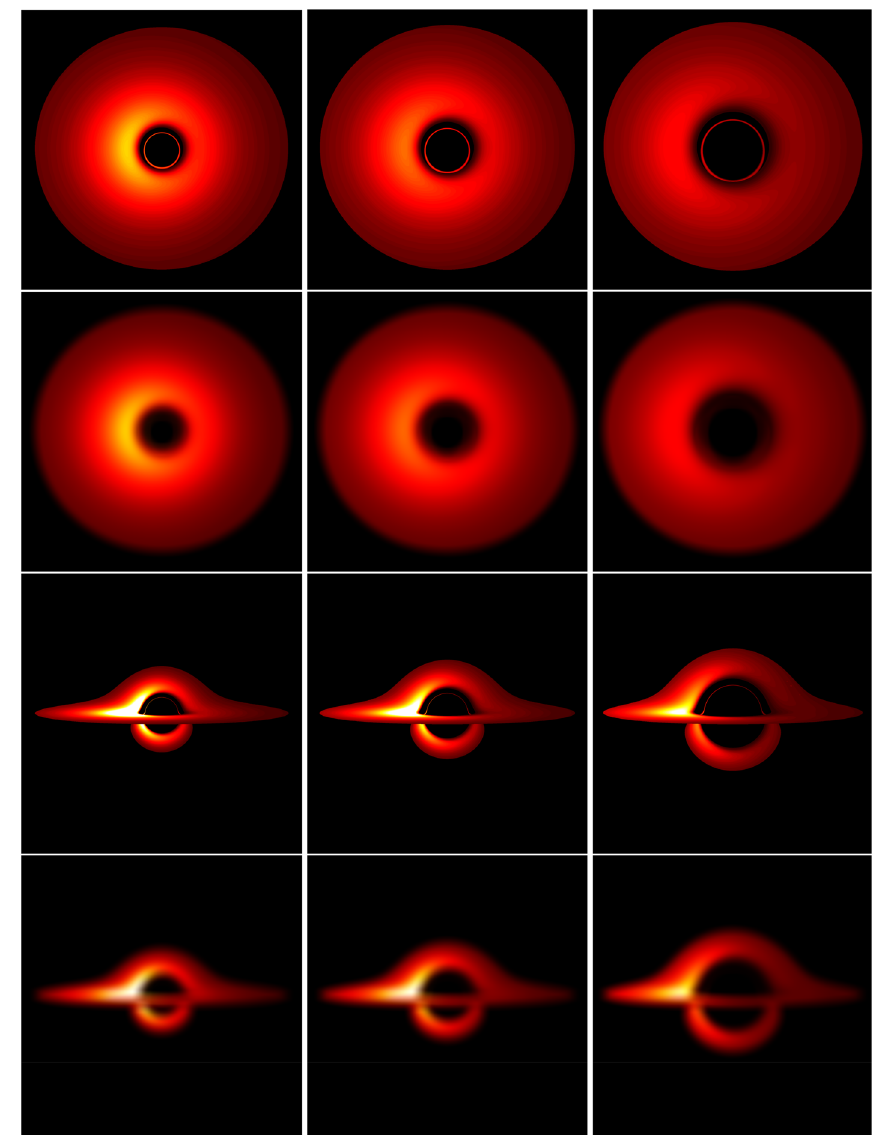
Fig. 15 Images from Fig.12 before (first and third row) and after (second and fourth row) blurring with a Gaussian filter in order to simulate the nominal resolution of the EHT. Evidently, the ring structures in the center of images are washed out after